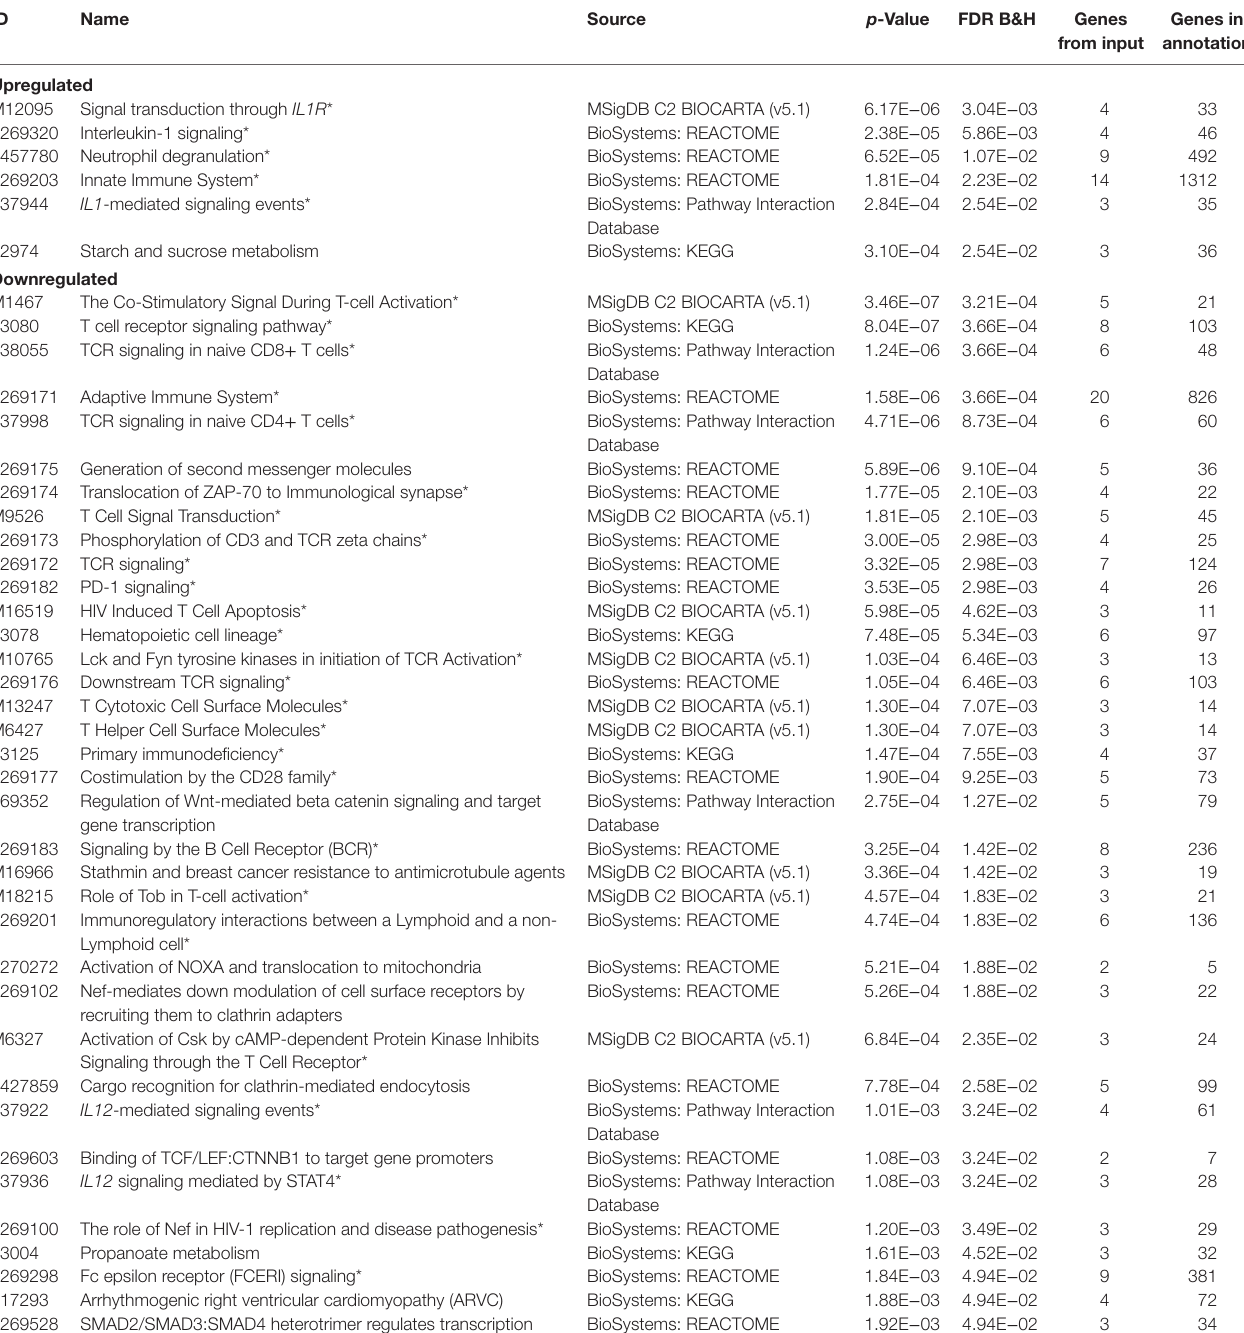
taBle 2 | Functionally enriched pathways from cross-study meta-analysis.